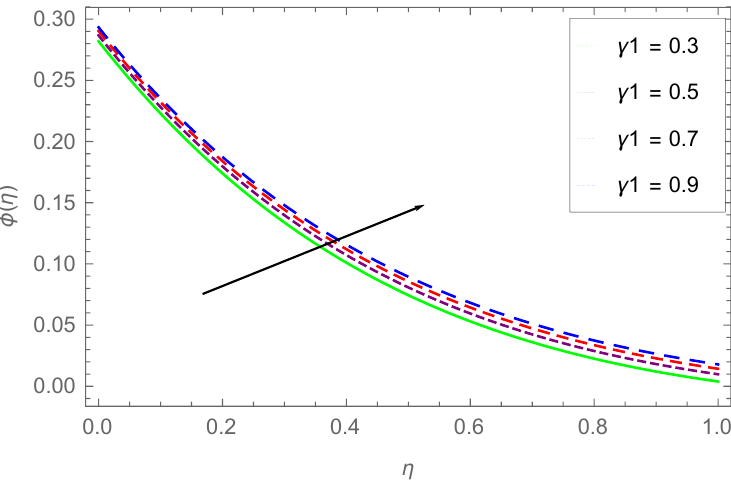
Figure 12. Influence of γ 1 over φ ( η )